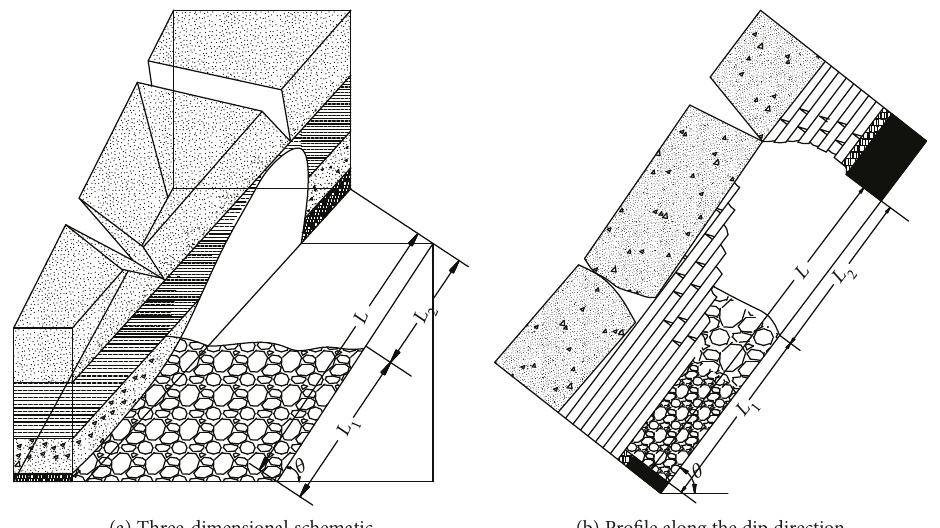
Figure 2: Schematic of the back fi ll in the